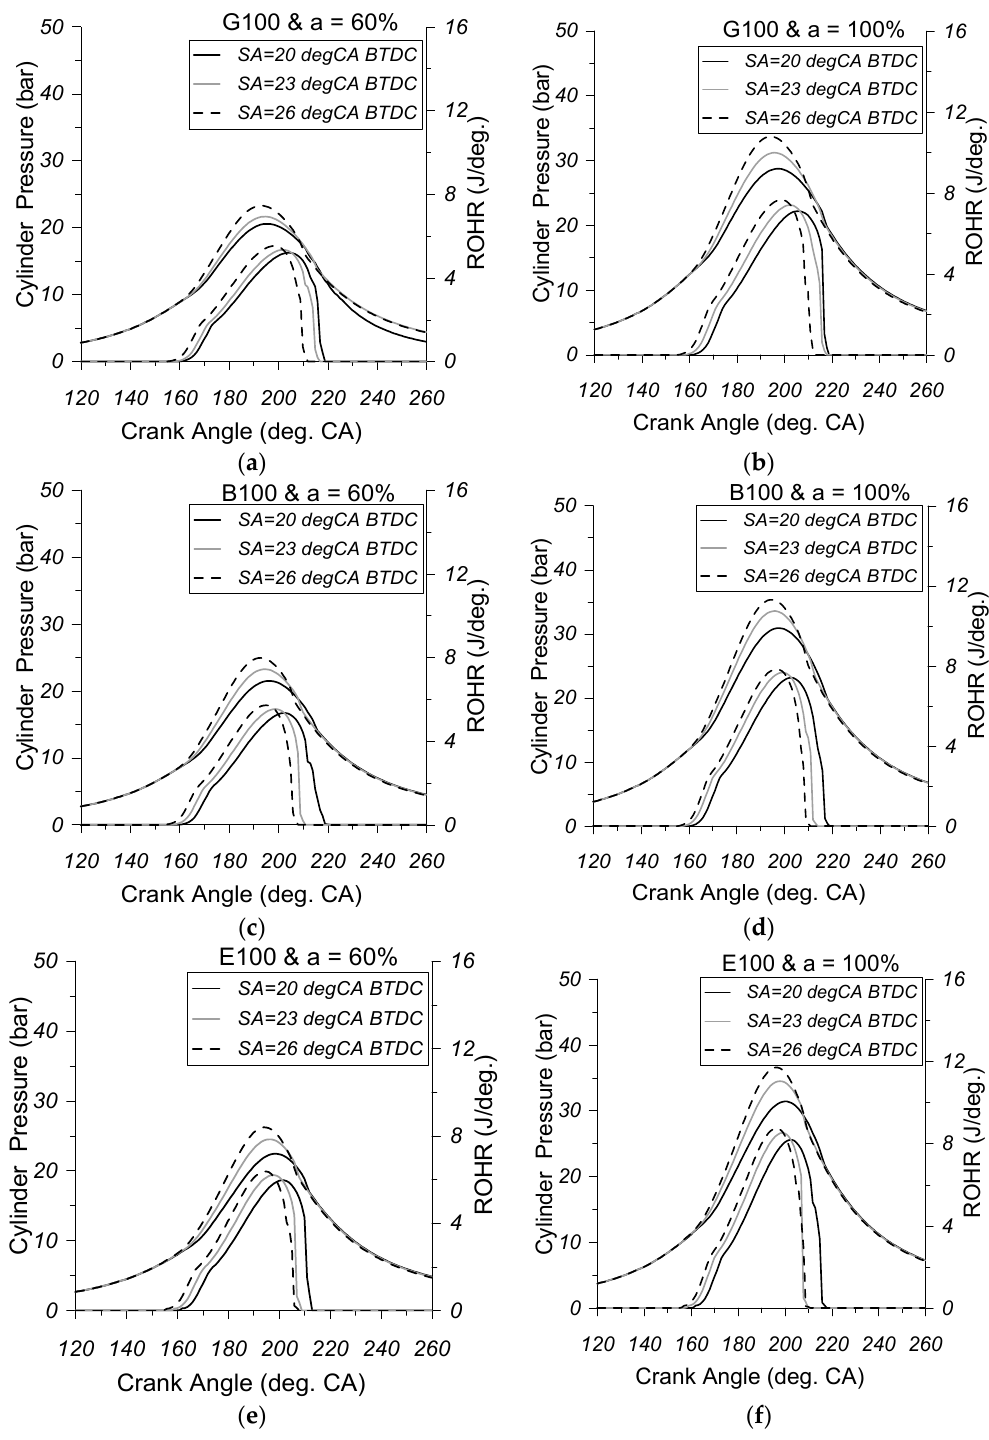
Figure 5. Calculated cylinder pressure and heat release traces for various spark timings, with G100 at 2400 rpm and 60% load ( a ); and 2400 rpm and 100% load ( b ); with B100 at 2400 rpm and 60% load ( c ); and 2400 rpm and 100% load ( d ); and with E100 at 2400 rpm and 60% load ( e ); and 2400 rpm and 100% load ( f ).